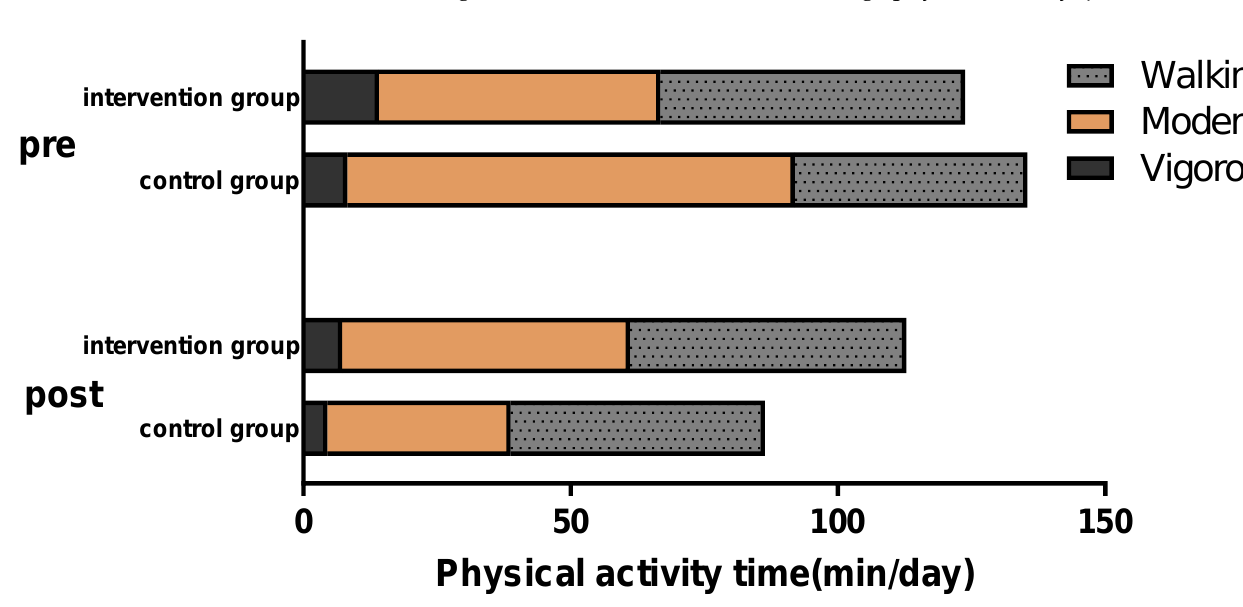
Figure 3. Pre- and post-intervention physical activity (including walking and moderate-to-vigorous physical activity, F = 3.798, p = 0.059, d = 0.38).